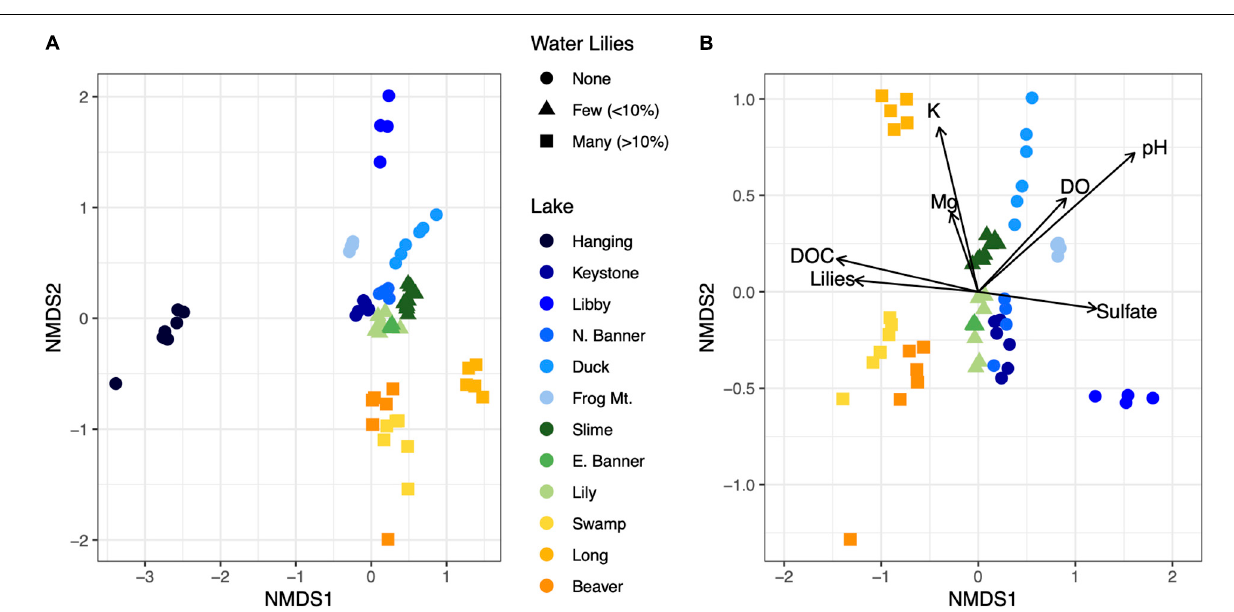
FIGURE 3 | NMDS ordination of Bray-Curtis dissimilarities for microbial communities from all 12 lakes (A) . Biogeochemical parameters overlayed on an NMDS ordination of microbial communities for all lakes except Hanging Lake, a non-water lily lake with elevated pH and ion concentrations (B) . Biogeochemical measures significantly associated with the ordination ( p < 0.01) are shown where the length of the arrow is proportional to the correlation coefficient